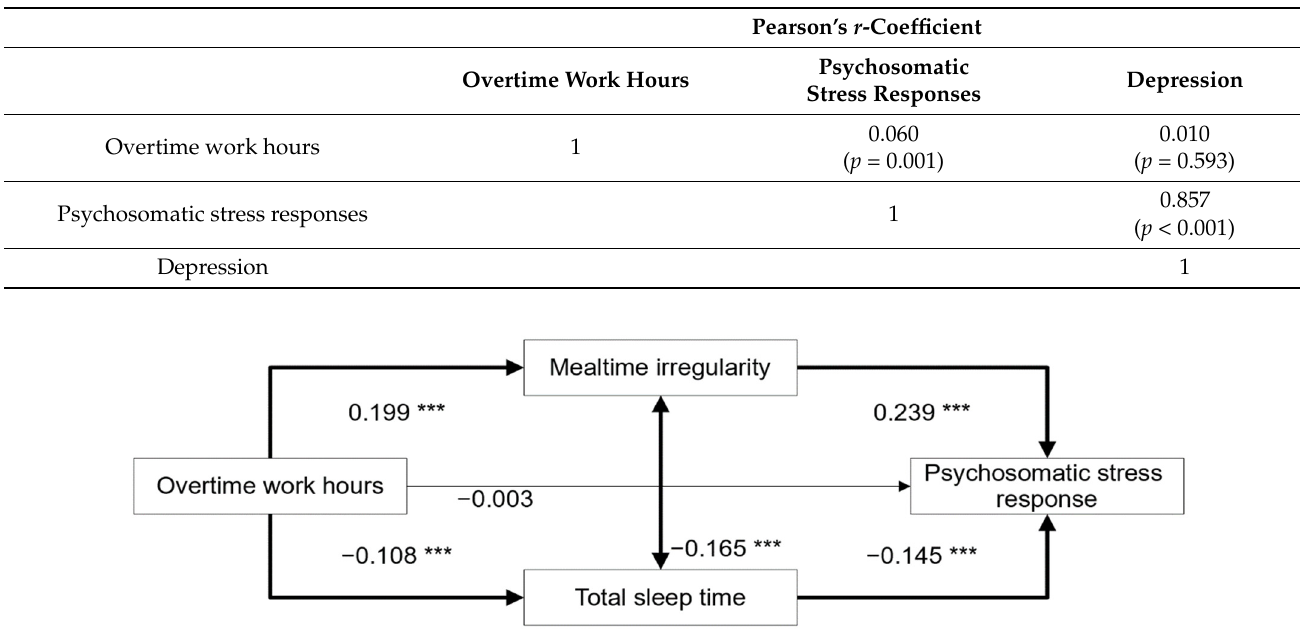
Table 2. Correlation between overtime work hours, psychosomatic stress responses, and depression.